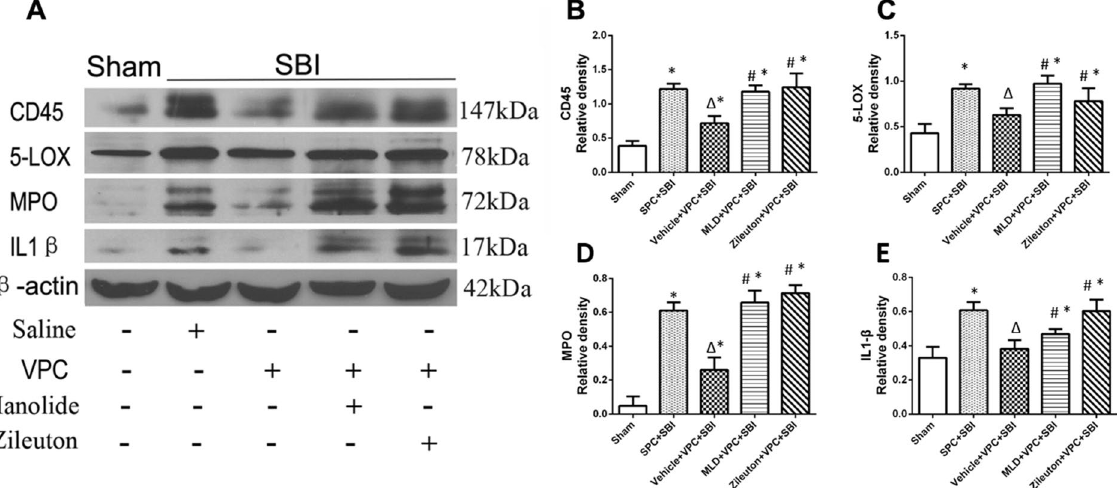
Figure 5. Venom preconditioning reduced inflammatory markers at the right frontal peri-resection site 24 h after SBI, which was reversed with Manoalide and Zileuton. (A) Representative western blot bands showing the changes in expression of inflammation-associated markers CD45, 5-LOX, MPO and IL-1 at the peri-resection site 24 h after SBI. The expression of CD45 (B) , 5-LOX (C) , MPO (D) and IL-1 β (E) were reduced in VPC + SBI rats compared to SPC + SBI group. Manoalide and Zileuton reversed the effects of VPC on the expression of all the inflammatory markers. * p < 0.05 vs Sham, ∆ p < 0.05 vs SPC + SBI, # p < 0.05 vs VPC + SBI. Data are shown as mean ± SD. n = 6/group. The full length western blot pictures are shown in Supplemental Figure